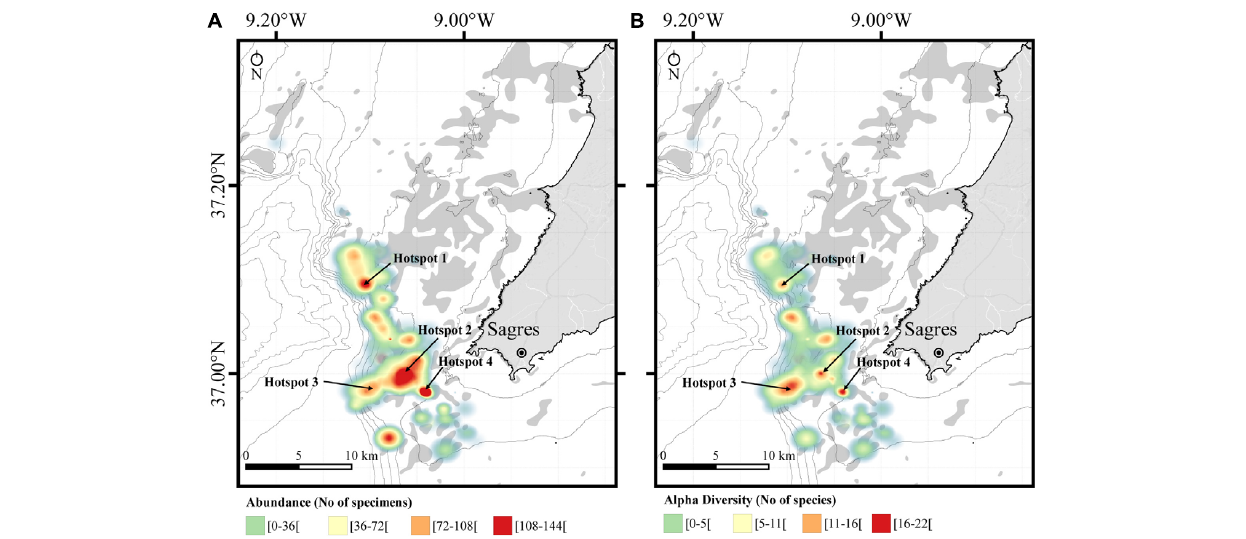
FIGURE 9 | Spatial distribution of coral bycatch and biodiversity (no. of species) caught as incidental catches in bottom-set gillnets in Sagres (southern Portugal). Identification of possible hotspots of coral gardens that should be protected from significant adverse impacts. Hotspots coordinates as the center point of the hotspots in WGS84 (GPS). Hotspot 1: N37.0952 W-9.1058; Hotspot 2: N36.99565 W-9.06177; Hotspot 3: N36.98156 W-9.10291; Hotspot 4: N36.98032 W-9.04086. (A) Density map of corals showing the hotspots based on the number of corals collected in each net deployed. (B) Diversity map of corals showing hotspots based on the diversity of corals collected in each net deployed. Coral diversity and abundance are displayed as heatmaps generated using triangular kernel density. Bathymetric isobaths are as follows: 50 m, 100–500 m (increments of 100 m), and > 500 m (increment of 200